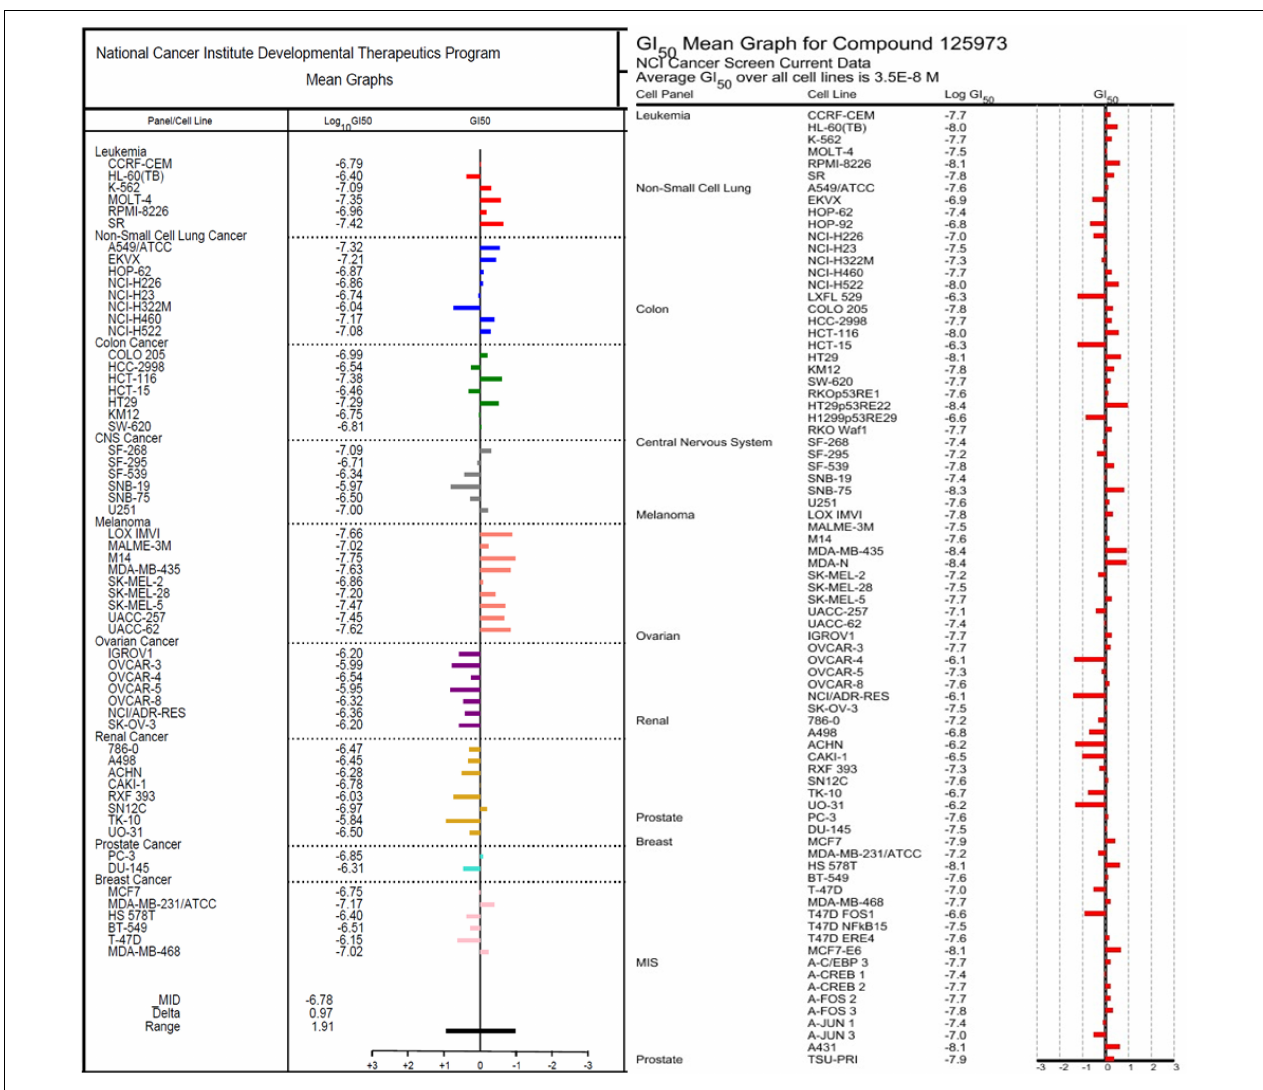
FIGURE 5 | Comparison of the GI 50 ’s between NSC763554 (Monanchocidin A) and Taxol. GI 50 is the calculated micro-molar concentration that results in 50% reduction of the measured protein at the end of drug-treatment compared to the beginning. The median log GI 50 for NSC763554 over all cell lines was